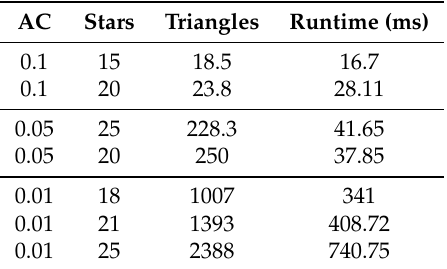
Table 1. Simulation runtime